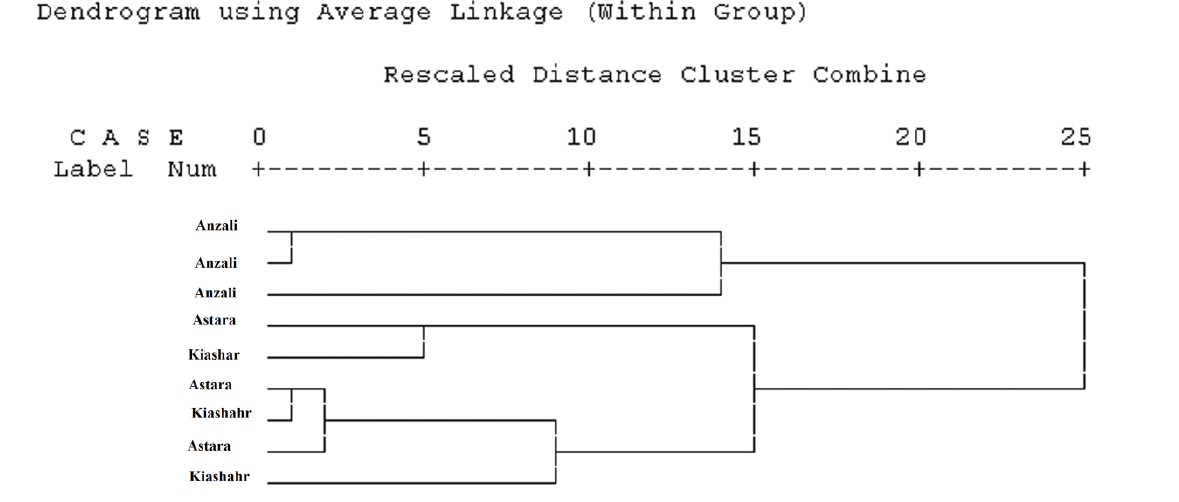
Figure 4. Dendrogram according to cluster analysis of elemental concentrations in the fish skin in different stations of the southern coasts of the Caspian